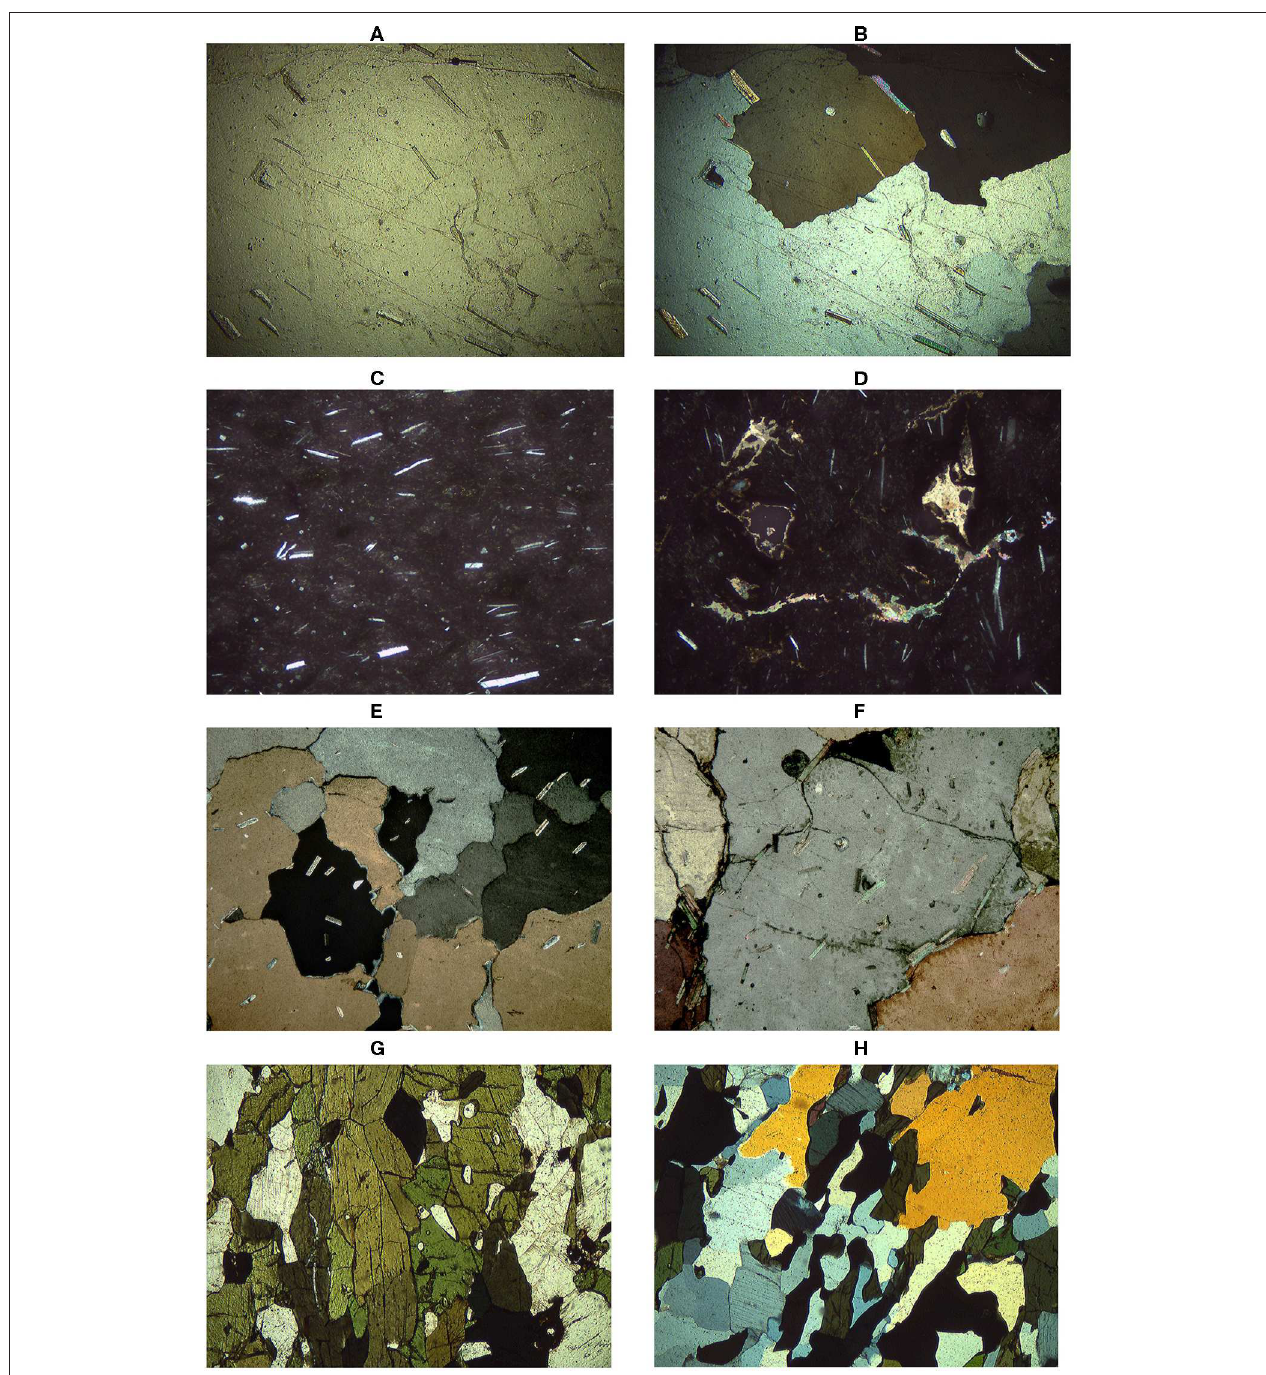
FIGURE 3 | Endonyo Osunyai 2: (A) Lineated muscovite in quartz (PPL 2 × horizontal field width 1.1mm); (B) same as (A), quartz crystals show undulatory extinction and corrugated boundaries (XP); Engelosin 2: (C) flow-aligned microphenocrysts of sanidine (XP 4 × horizontal field width 0.55mm); (D) sub-parallel sanidine microphenocrysts and interstitial sericite with a silky texture (XP 2 × horizontal field width 1.1mm); Gol Mountains (PPP1): (E) randomly oriented muscovite included in and interstitial to quartz (XP 2 × horizontal field width 1.1mm); Gol Mountains (DDD1): (F) sub-parallel muscovite included in and interstitial to quartz (XP 2 × horizontal field width 1.1mm); Kelogi 10: (G) hornblende and aegirine (PPL 4 × horizontal field width 0.55mm); (H) plagioclase, quartz, hornblende, and aegirine (XP 4 × horizontal field width 0.55mm).